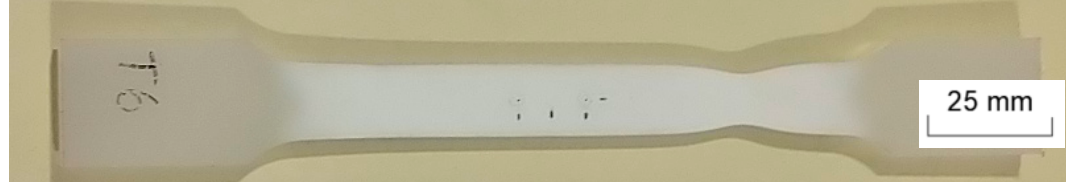
Figure 18. Uniaxial tensile test sample after testing.